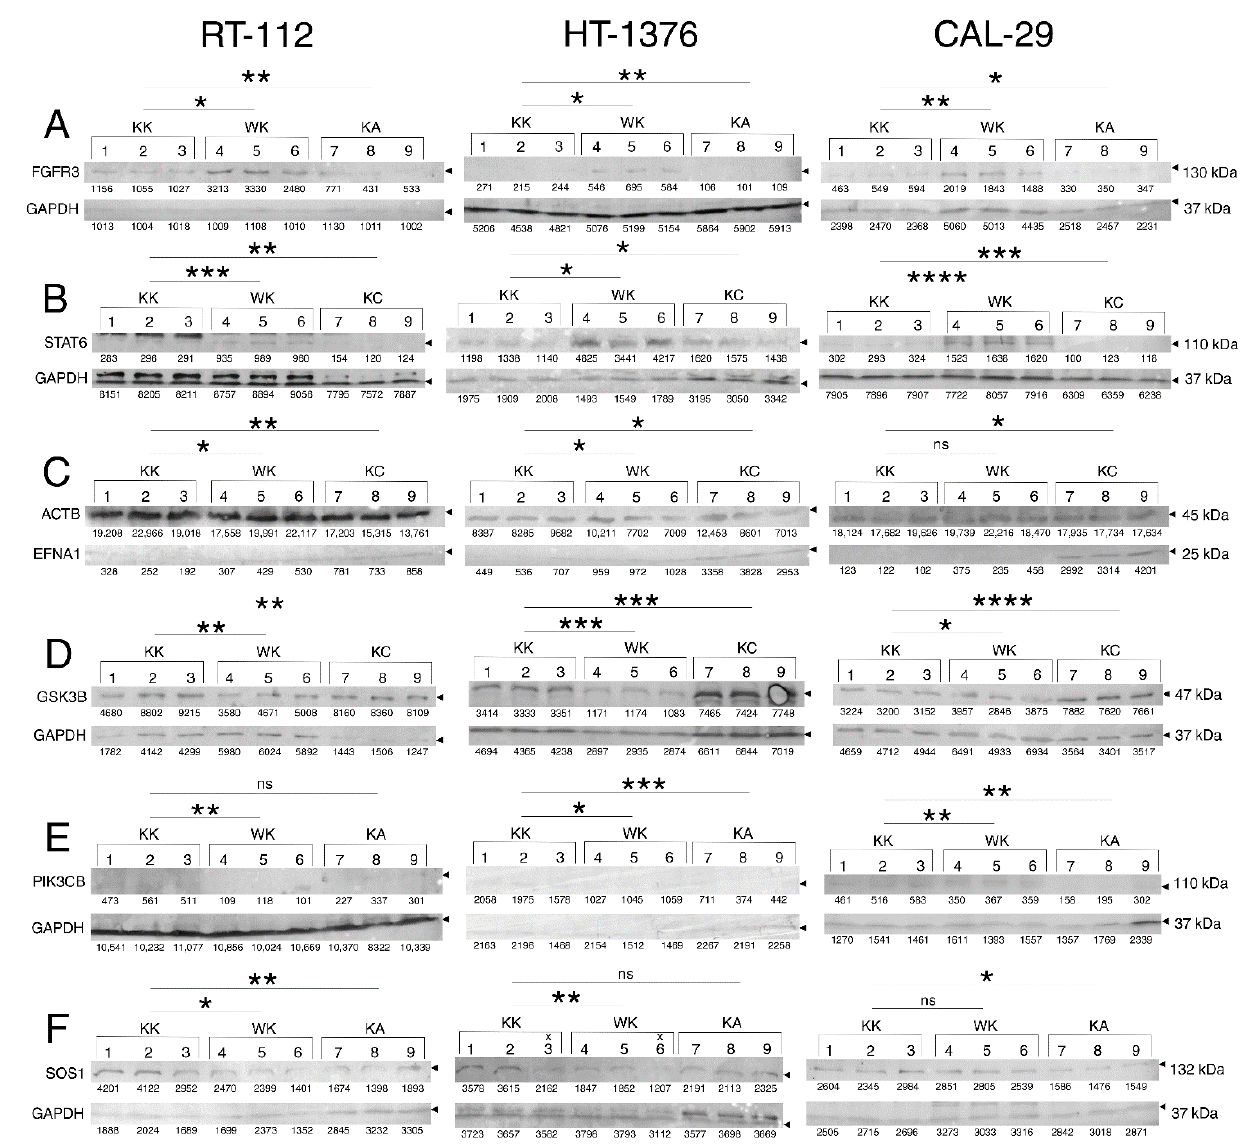
Figure 6. Validation of selected CAGE-seq observations on the protein level. ( A ) FGFR3. ( B ) STAT6. ( C ) EFNA1. ( D ) GSK3B. ( E ) PIK3CB. ( F ) SOS1. Stars represent statistical significance; p -value < 0.05 (*), p -value < 0.01 (**), p -value < 0.001 (***), p -value < 0.0001 (****).